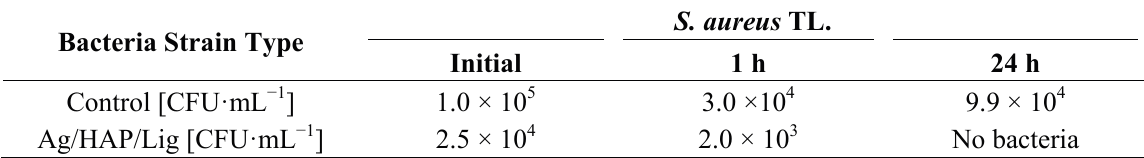
Table 5. Reduction of viable cell number of S. aureus TL after incubation with Ag/HAP/Lig coating for 0, 1 and 24